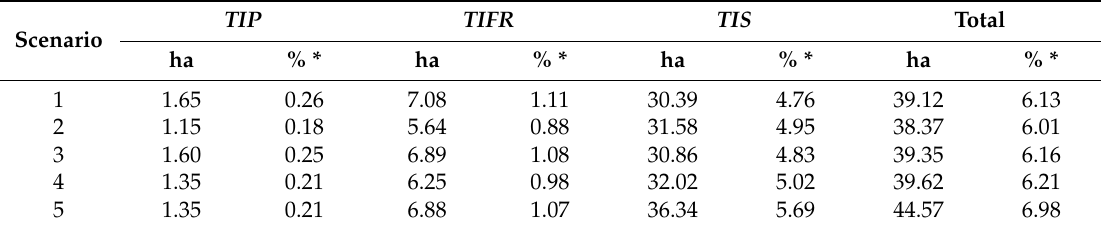
Table 5. Estimate of the environmental impact brought about by the total yard infrastructure ( TIP ), forest roads ( TIFR ), and skidtrails ( TIS ) in each